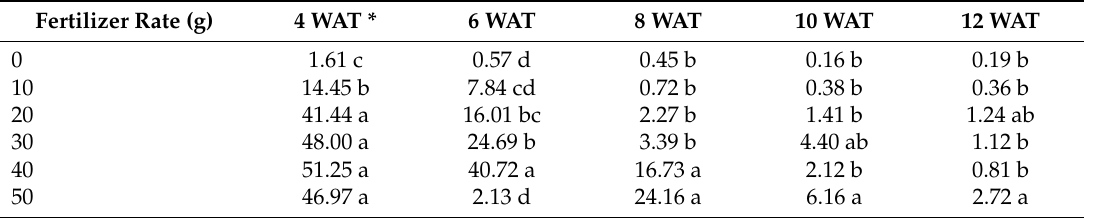
Table 6. Leachate (nitrate runo ff ) collected after irrigation (mg NO 3 − / L) collected for a plant in a single pot with di ff erent rates of CRF at di ff erent weeks after fertilizer treatment in Justicia brandegeana . Fertilizer Rate